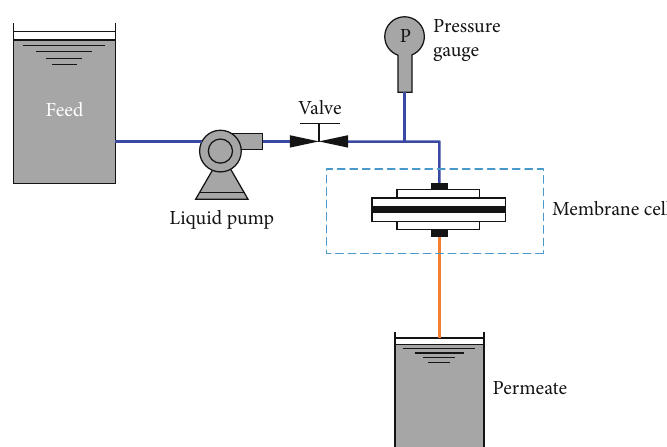
Figure 3: Schematic of membrane testing experimental laboratory setup.